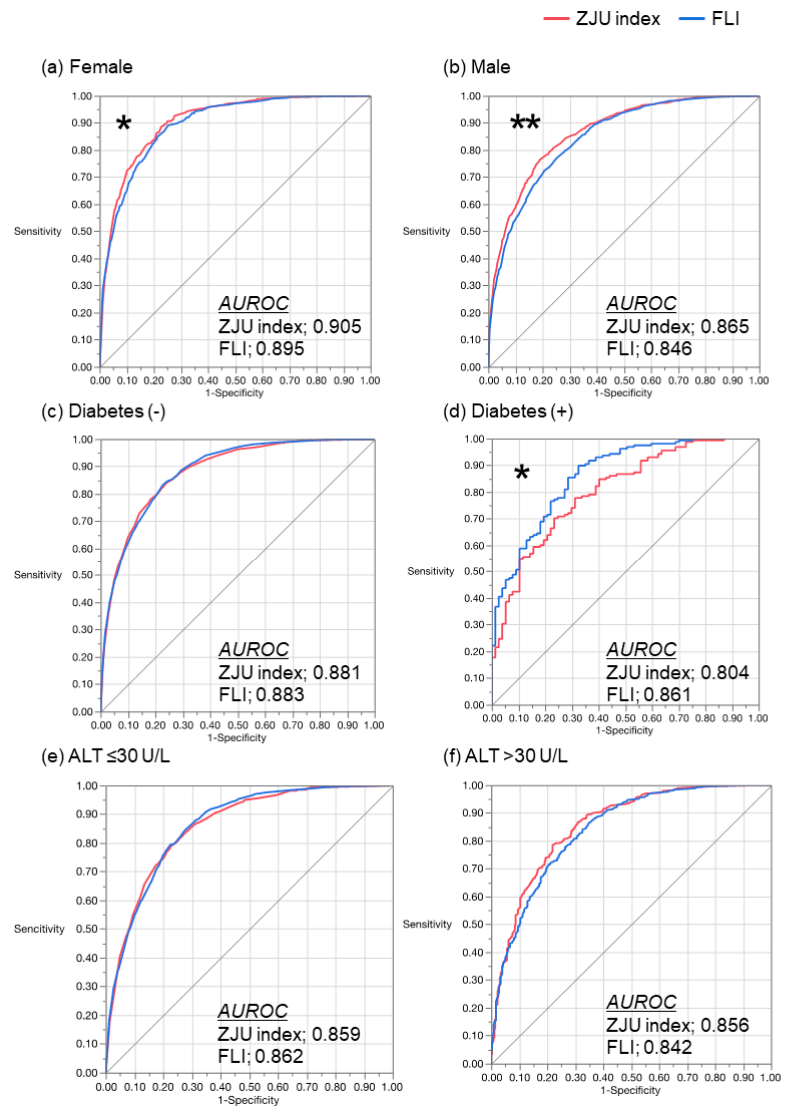
Figure 4. Comparison between the ZJU index and FLI under specific conditions. ROC curve of the ZJU index (red) and FLI (blue) for diagnosis of NAFLD. The ZJU index and FLI were compared in ( a ) females, ( b ) males, ( c ) subjects without diabetes, ( d ) subjects with diabetes, ( e ) subjects with ALT within the reference range ( ≤ 30 U/L), and ( f ) subjects with ALT > 30 U/L. The ZJU index showed a greater AUROC than the FLI when the subjects were stratified by gender. The FLI showed a greater AUROC than the ZJU index in the patients with diabetes. * p < 0.05. ** p < 0.001 by the DeLong test. AUROC, area under the receiver operating characteristic; FLI, fatty liver index; NAFLD, nonalcoholic fatty liver disease; ZJU, Zhejiang University.